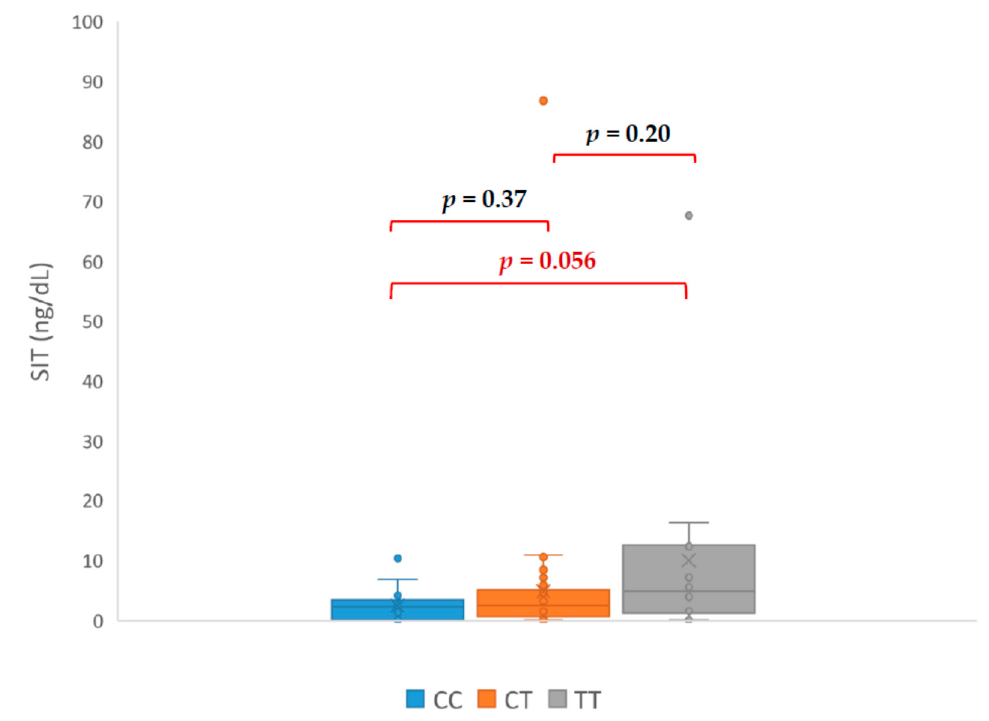
Figure 3. Differences in aldosterone concentrations in saline infusion suppression test (SIT—saline infusion test).